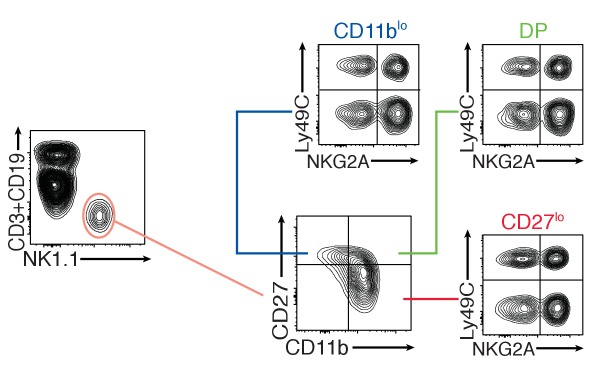
Flow cytometry density plots presenting the analysis strategy to compare educated versus uneducated NK cells in C57BL/6 mice and the phenotypically equivalent subsets in B2m−/− mice.Expression of the surface markers CD11b and CD27 by CD3-CD19-NK1.1+ splenocytes defines three maturation subsets (CD11blo, DP and CD27lo), each of these subsets is further divided into four subsets according to the expression of the inhibitory receptors NKG2A and Ly49C.